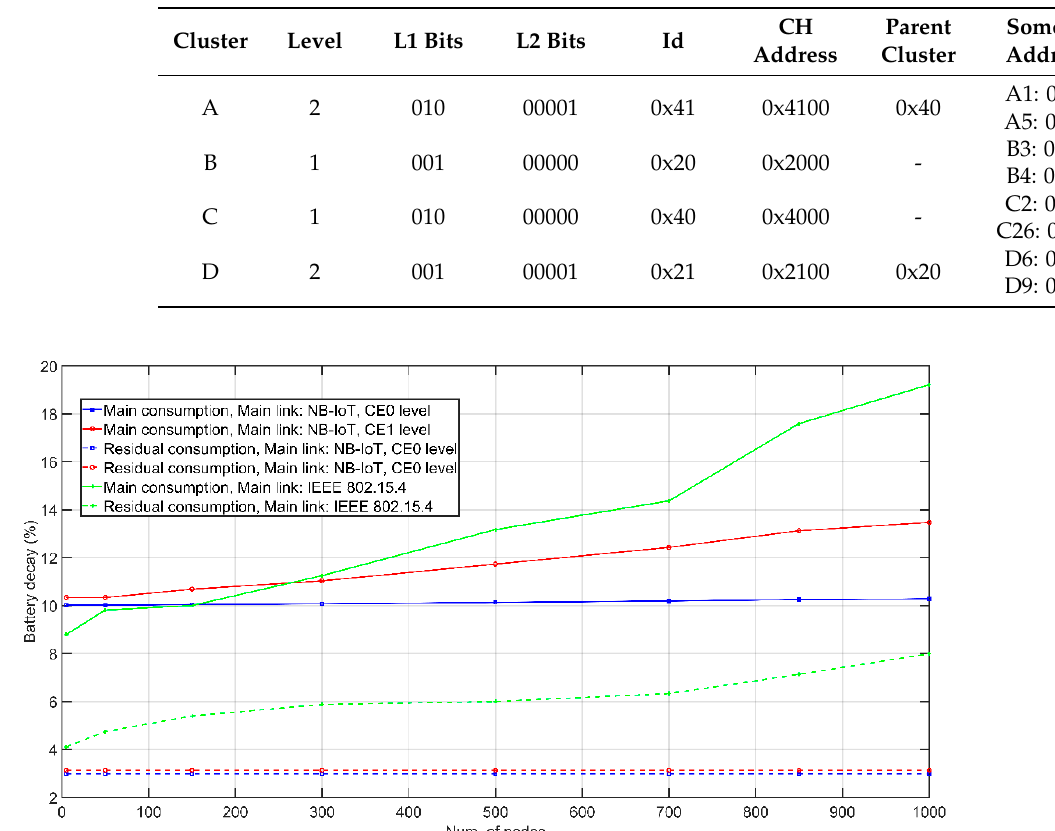
Figure 6. Annual battery decay of the combined network as a function of the number of nodes.